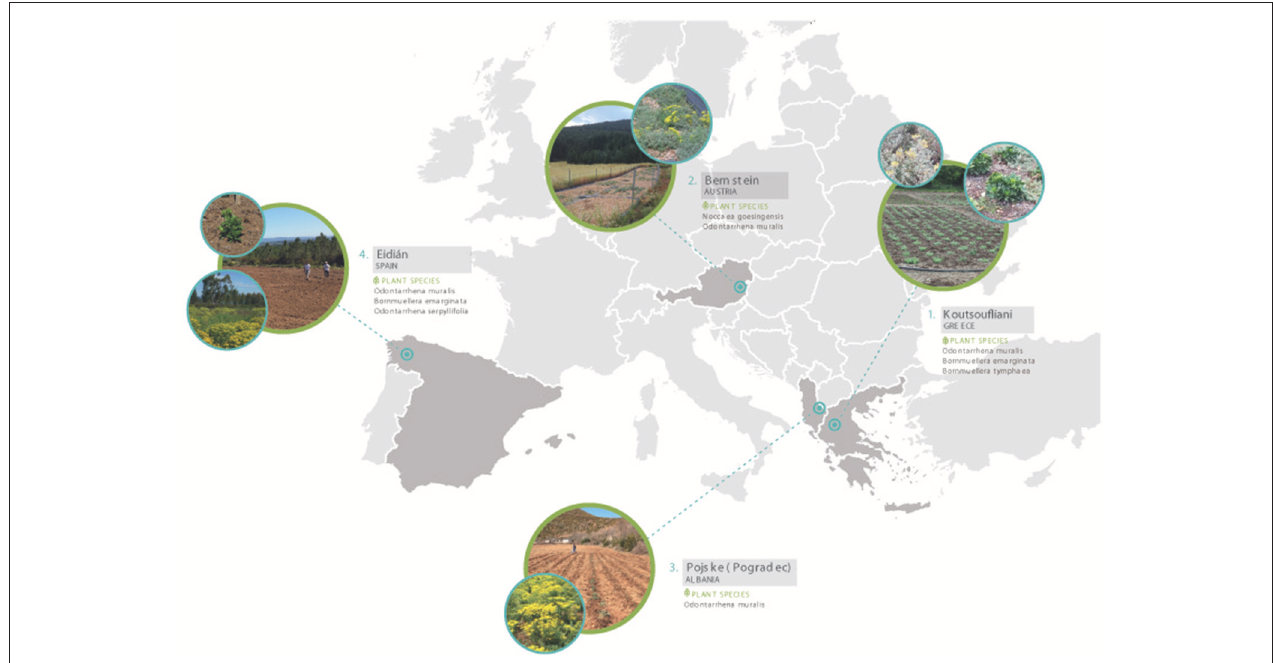
FIGURE 3 | European network of nickel agromining field